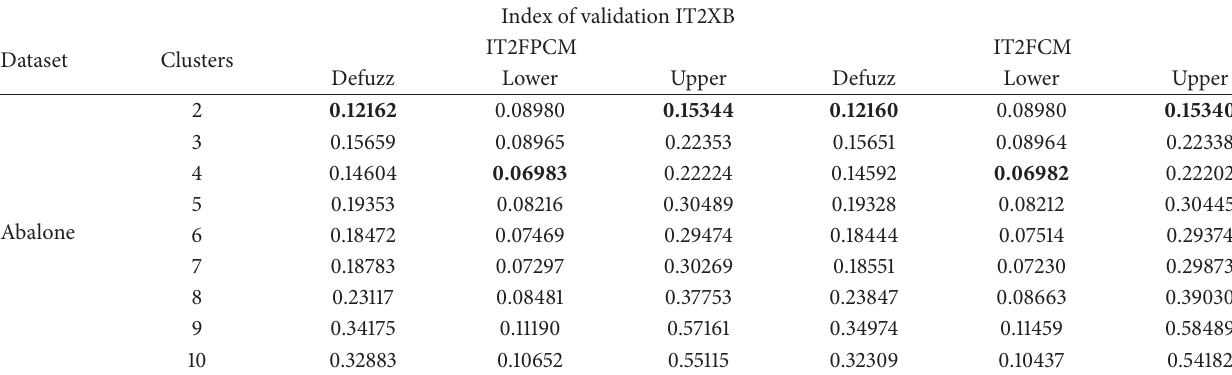
Table 19: Results of the IT2XB validation index to Abalone dataset clustering using IT2FPCM and IT2FCM algorithm with 𝑚 = [1.5, 2.5] and 𝜂 = [1.5, 2.5] as parameters.